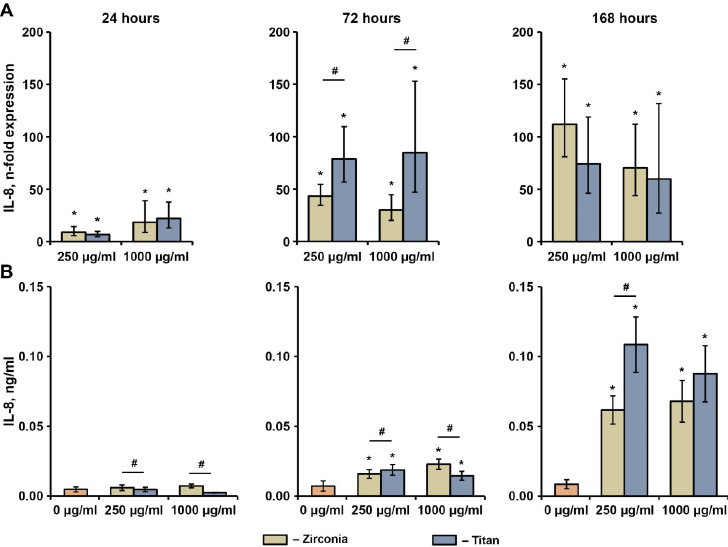
Figure 5. Effects of NPs on the basal IL-8 expression in hG-MSCs. The hG-MSCs were cultured in the absence or in the presence of different NPs for 24 h, 72 h, or 168 h. The resulting IL-8 gene expression ( A ) and IL-8 protein production ( B ) rates were measured via qPCR and ELISA, respectively. ( A ) Y-axis represents n-fold expression of IL-8 in hG-MSCs cultured with NPs compared to unstimulated control (n-fold expression = 1). N-fold expression was calculated using the 2 −ΔΔCt method, using GAPDH as the reference gene. ( B ) Y-axis shows the concentration of IL-8 in the conditioned media Data are presented as means ± s.e.m. of six independent experiments performed with hG-MSCs isolated from six different donors. Note: *—significantly higher compared to control, p < 0.05; #—significantly different between Ti NPs and Zr NPs, p < 0.05.